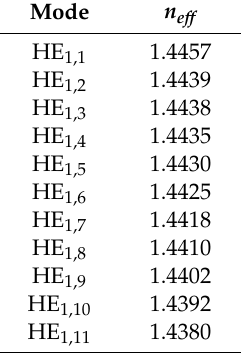
Table 1. E ff ective refractive indexes of the core mode and the chosen 10 cladding modes at 1550